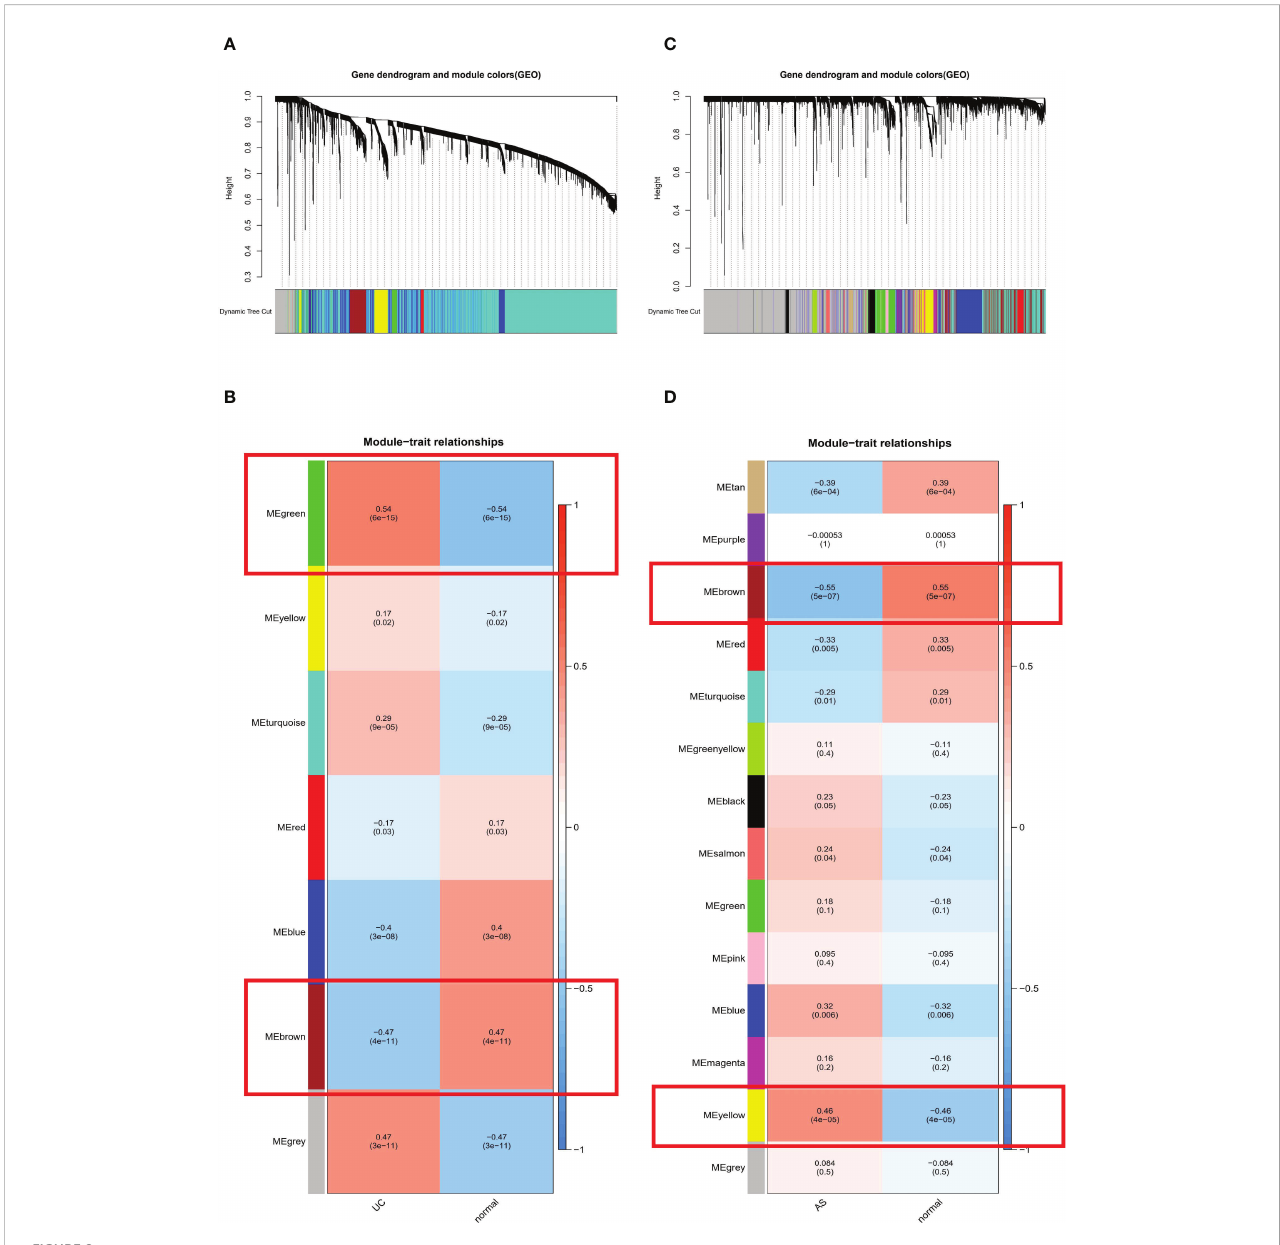
FIGURE 2 (A) The cluster dendrogram of co-expression in UC. (B) Correlation between modules and clinical traits in UC. (C) The cluster dendrogram of co- expression in AS. (D) Correlation between modules and clinical traits in